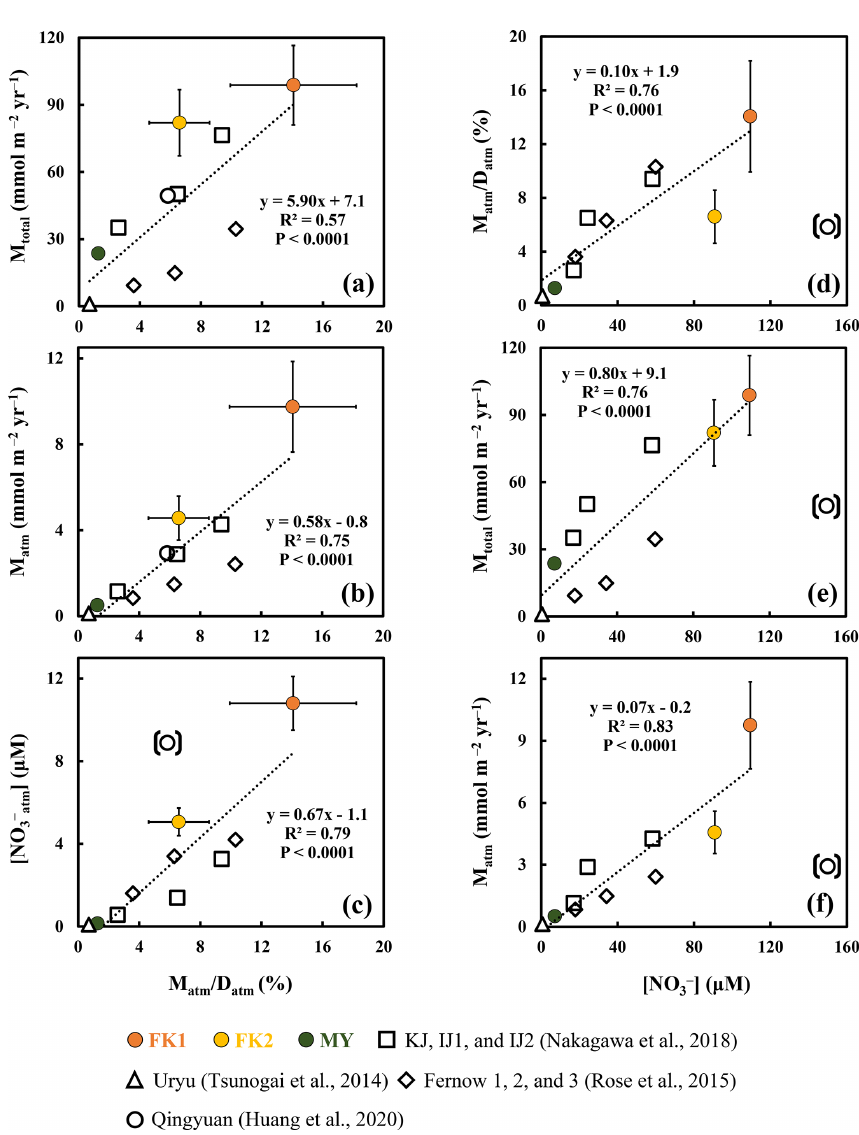
Figure 3. Annual export flux of nitrate per unit area ( M total ) plotted as a function of the M atm /D atm ratio in each forested catchment (a) ; the annual export flux of unprocessed atmospheric nitrate per unit area ( M atm ) plotted as a function of the M atm /D atm ratio (b) ; the average concentration of NO − ([NO − ]) plotted as a function of the M atm /D atm ratio (c) ; the M atm /D atm ratio plotted as a function of the 3 atm 3 atm average concentration of nitrate ([NO − ]) (d) ; the M total plotted as a function of [NO − ] (e) ; the M atm plotted as a function of [NO − ] (f) 3 3 3 (FK1: orange circles; FK2: yellow circles; MY: green circles). Those determined for the forested catchments in past studies are plotted as well (Qingyuan: white circle, Huang et al., 2020; KJ, IJ1, and IJ2: white squares, Nakagawa et al., 2018; Fernow 1, 2, and 3: white diamonds, Rose et al., 2015; Uryu: white triangle, Tsunogai et al., 2014). The data obtained in the Qingyuan forested catchment are shown in parentheses and excluded from the calculation to estimate correlation coefficients (see text for the